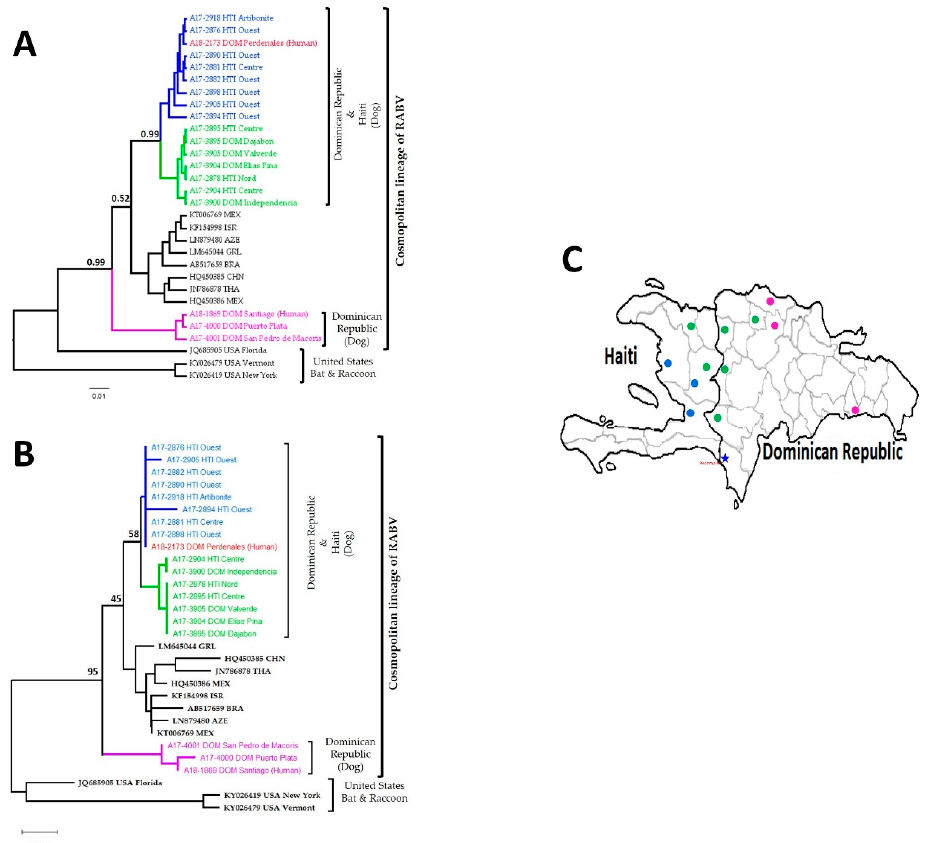
Figure 3. Molecular phylogenetic analysis using 115 bp sequences generated from LN34 amplicons. ( A ) The Bayesian evolutionary analysis sampling tree (BEAST) showed that the human rabies case (A18_2173) grouped with samples from HTI. The major nodes are labelled with the posterior probabilities. * Posterior values > 0.5 are shown at each node. ( B ) The neighbor joining tree agreed with the BEAST tree for the major clades and showed strains with identical sequences. The selected nodes are labelled with bootstrap values. ( C ) The geographic location of samples from HTI and DOM. The blue star is the location where the patient was infected.